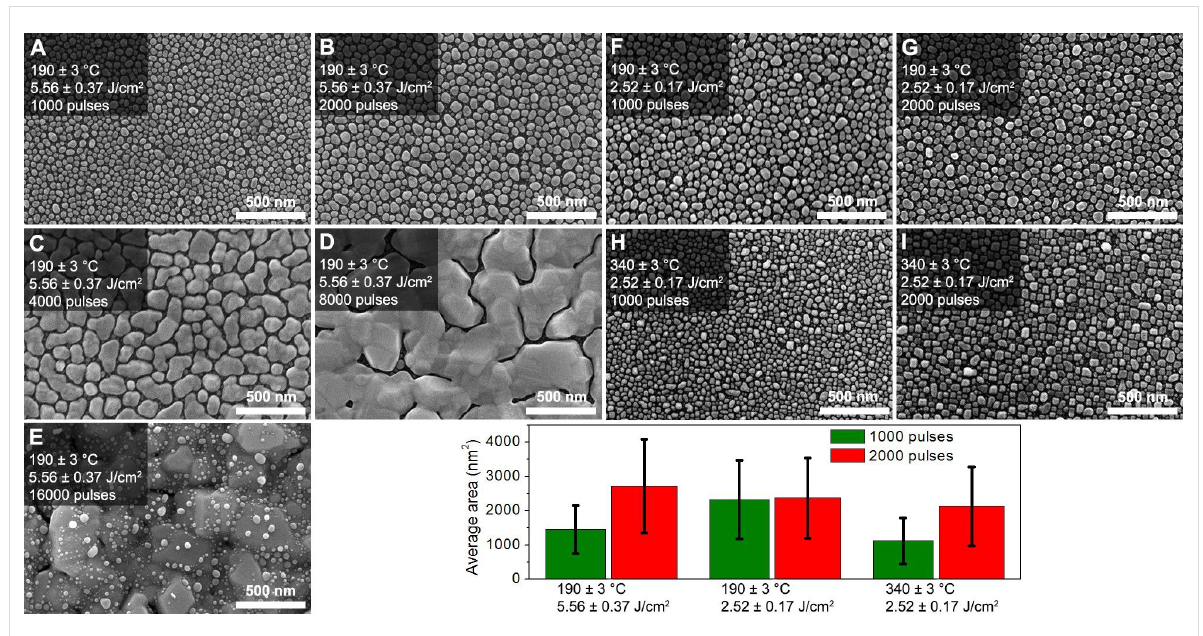
Figure 2: SEM images of the nanostructured silver films deposited on Si substrates by the PLD method using different process parameters. A bar graph showing the average surface of the silver nanoislands as a function of the deposition parameters for 1000 and 2000 laser pulses.